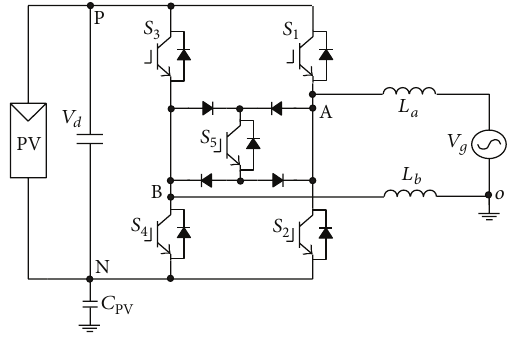
Figure 1: Schematic diagram of proposed inverter.